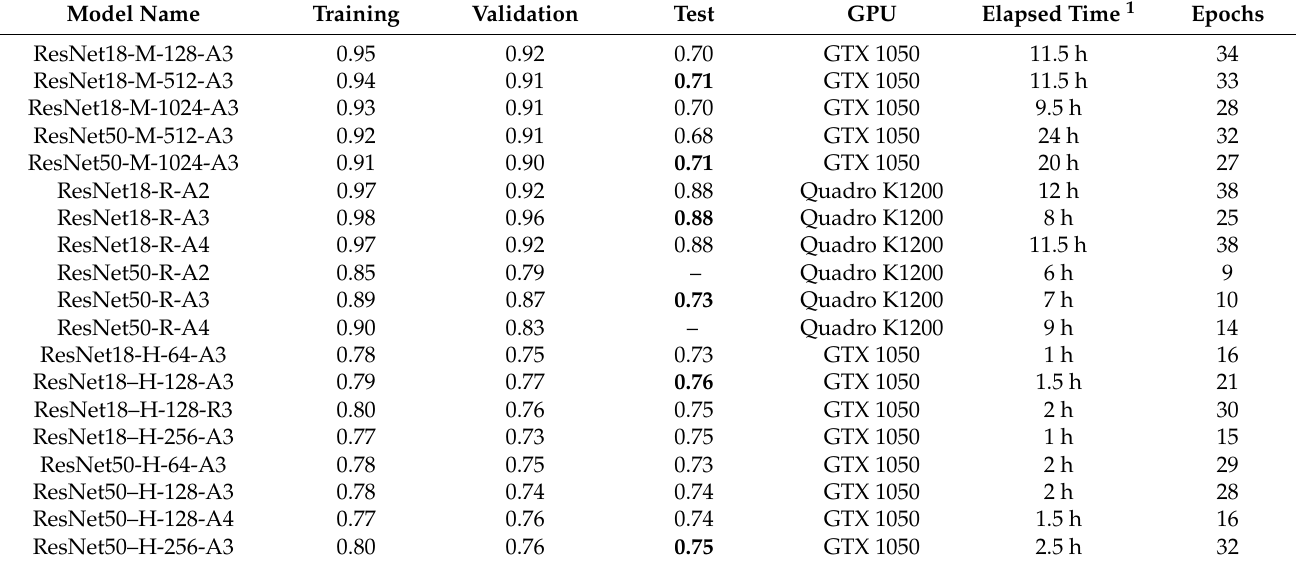
Table A2. Accuracy obtained for the primary task and other training information. The bold indicates best performing in